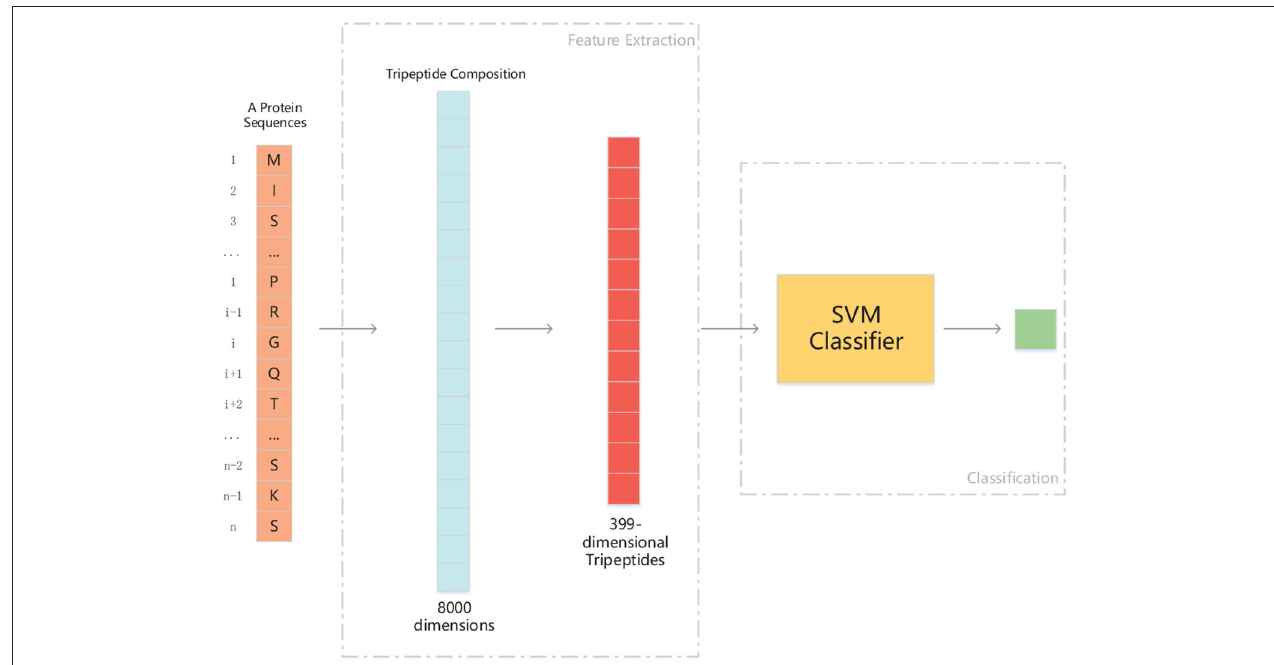
FIGURE 3 | The structure of PM-OTC model. The input data is whole protein sequence. First, through extracting tripeptides from raw sequence, 8000-dimensional TPC are obtained. And then, TPC constitute a feature vector of 399 dimensions by ANOVA, which is fed into the SVM classifier for